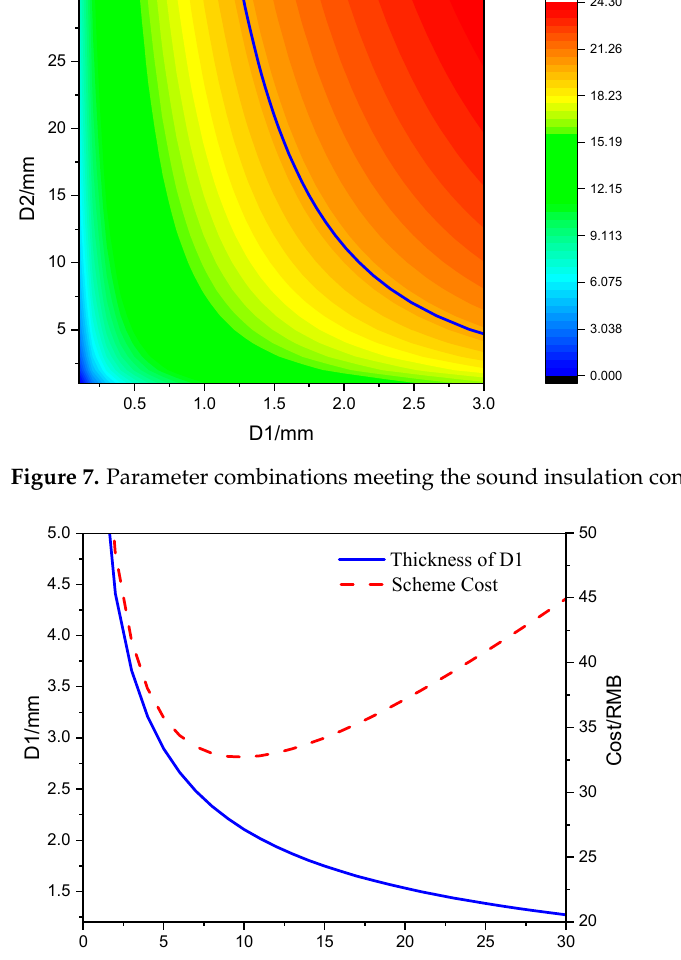
Figure 7. Parameter combinations meeting the sound insulation conditions (2D plot).